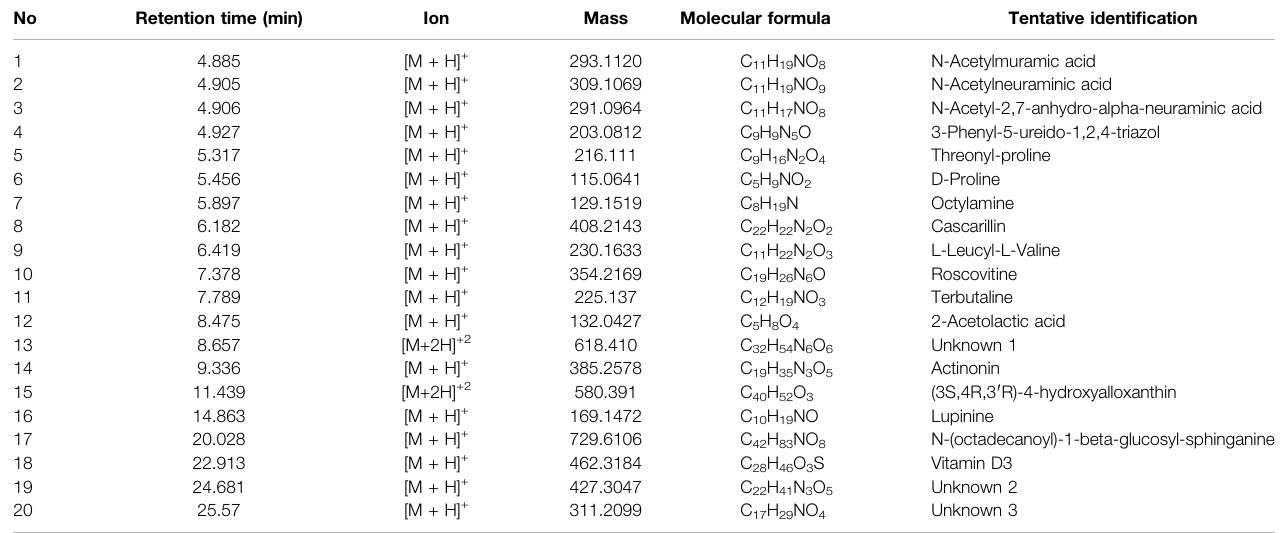
TABLE 1 | Metabolites detected from hydrolyzed birds nest (HBN) using LCMSQTOF. No Retention time (min) Ion Mass Molecular formula Tentative identi fi